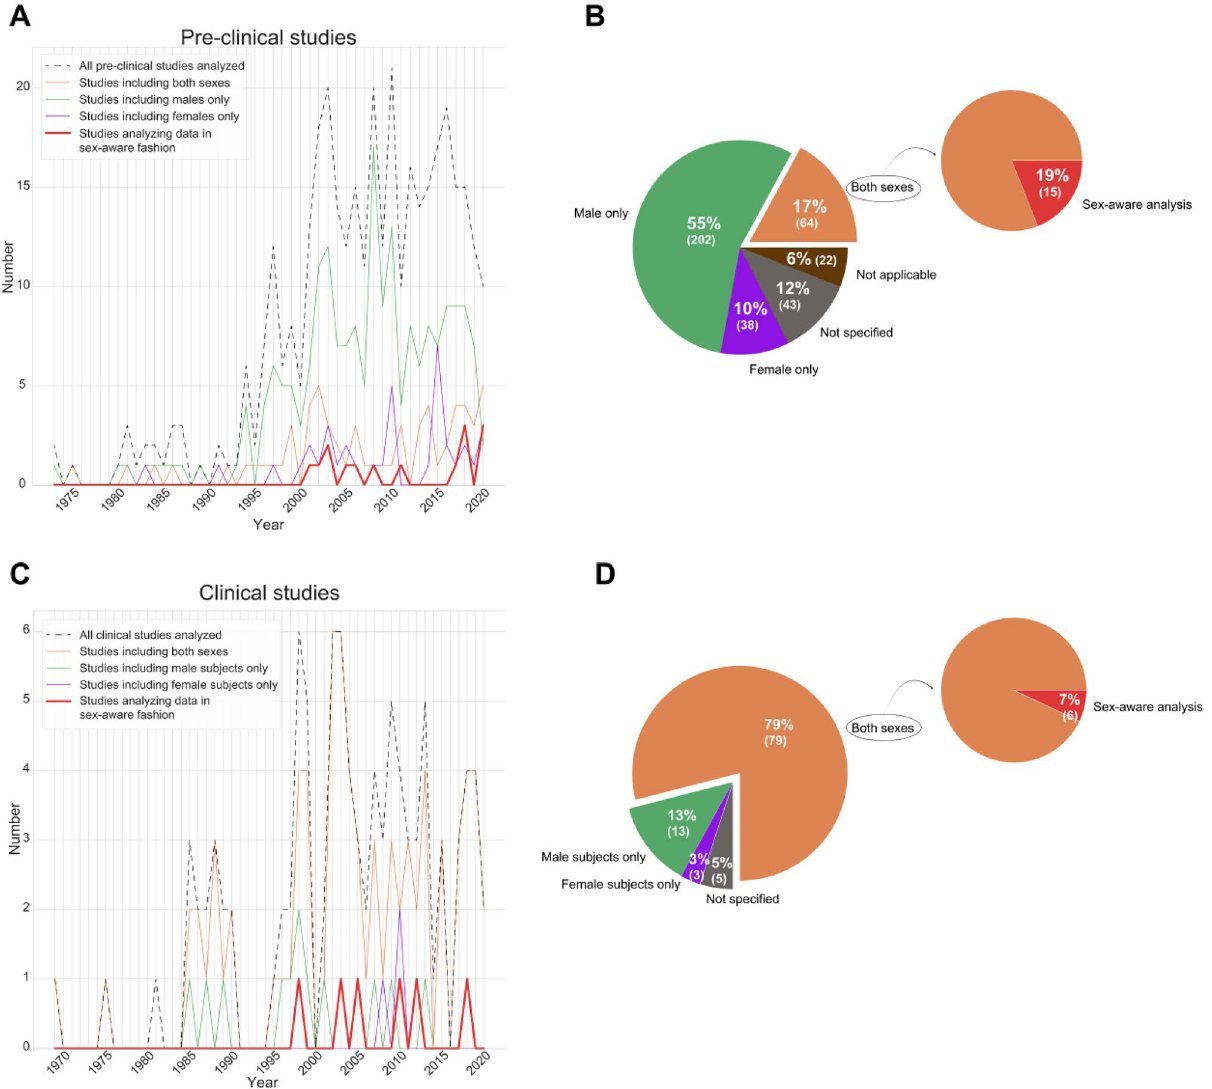
Figure 2. Most prostaglandin studies have not been analyzed with sex as a biological variable. ( A ) Line plot showing the inclusion of male, female or both sexes in pre-clinical studies from 1973 to 2020 and the number of studies that have been analyzed separated by sex (red line). ( B ) Pie charts showing the overall percentage of pre- clinical studies that include male, female or both sexes from 1973 to 2020. ( C ) Line plot showing the inclusion of male, female or both sexes in clinical studies from 1969 to 2020, including the studies that have analyzed the data separated by sex (red line). ( D ) Pie charts showing the overall percentage of clinical studies that include male, female or both sexes from 1969 to 2020. Note: studies where the sex of animals/subjects is not clear or specified are not shown in the line plots, please refer to supplementary files